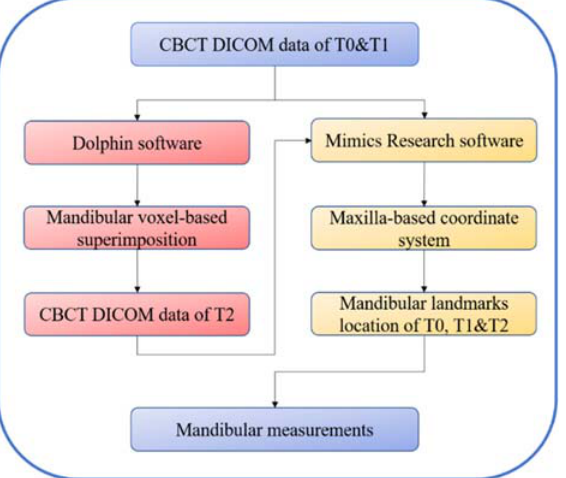
Figure 6. Schematic diagram of the process of this method. T0, before treatment; T1, after treatment, which was simulated via mandibular rearrangement; T2, after mandibular voxel-based superimpo- sition on T1 CBCT data.